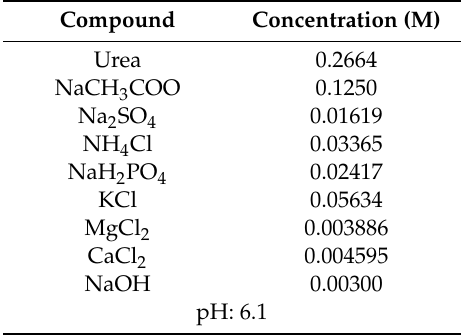
Table 1. Composition of fresh urine 1